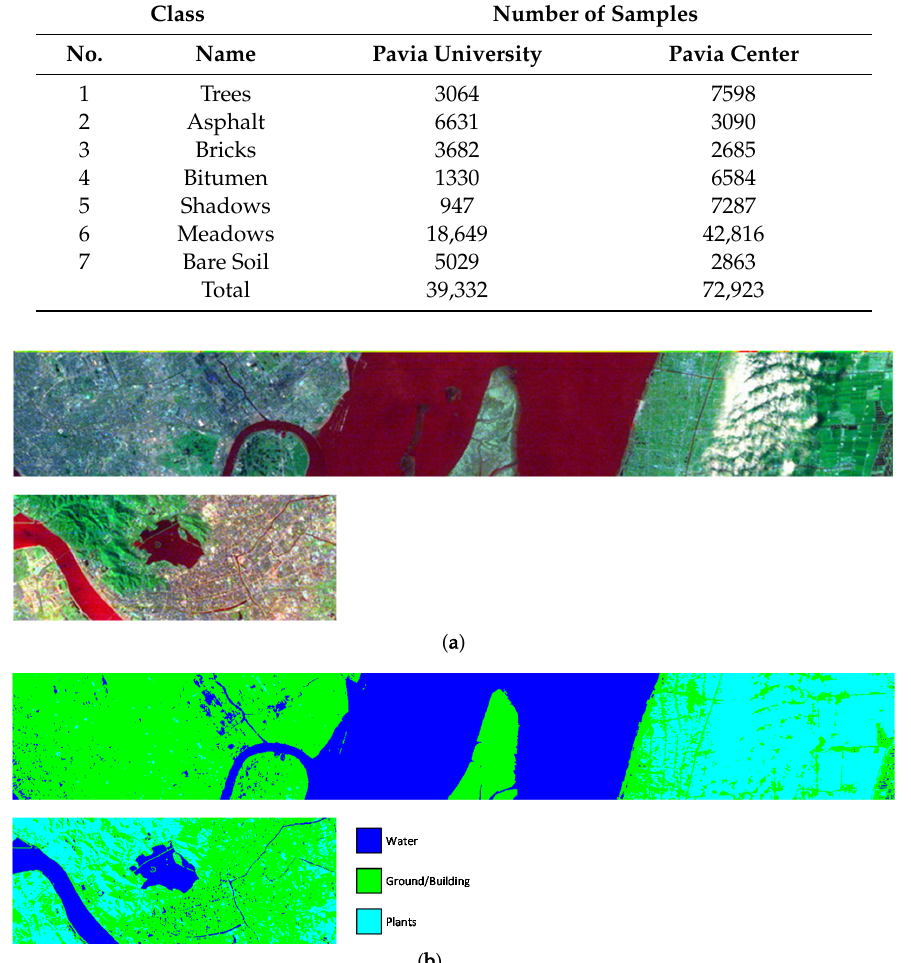
Figure 5. Source and target scenes in Shanghai–Hangzhou datasets. Top: Shanghai. Bottom: Hangzhou. (a) False-color image. (b) Ground truth. Table 4. Network parameters of TDDA.